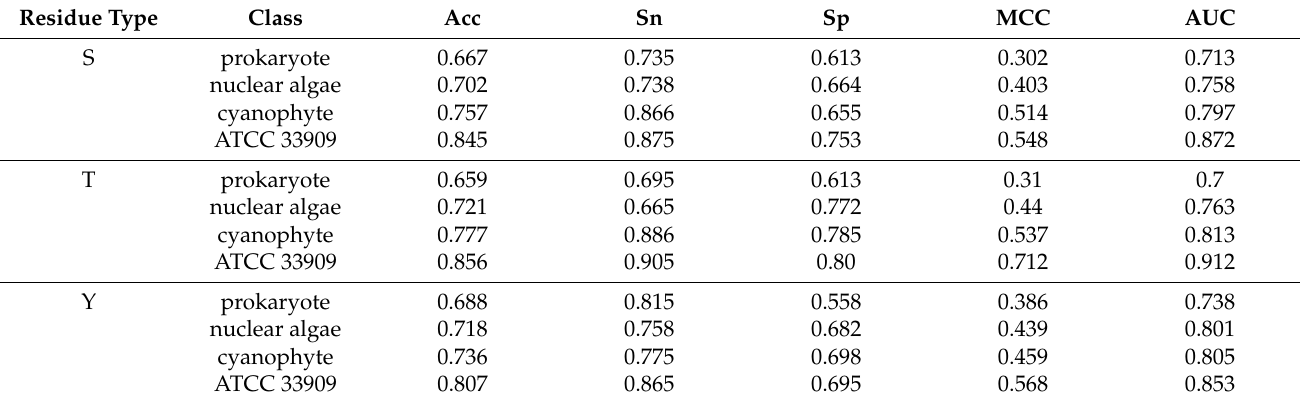
Figure 3. Under the training datasets with different sizes, boxplots of the ACCs achieved by EcapsP, CapsPTM, CNN, DeepIPS, and DeepPhos on the same independent test set. The X-axis represents the ratios of the number of samples in the new training datasets to that in the original training dataset. For each ratio, the simulation experiments are repeated 50 times. Table 5. Prediction results under different biological